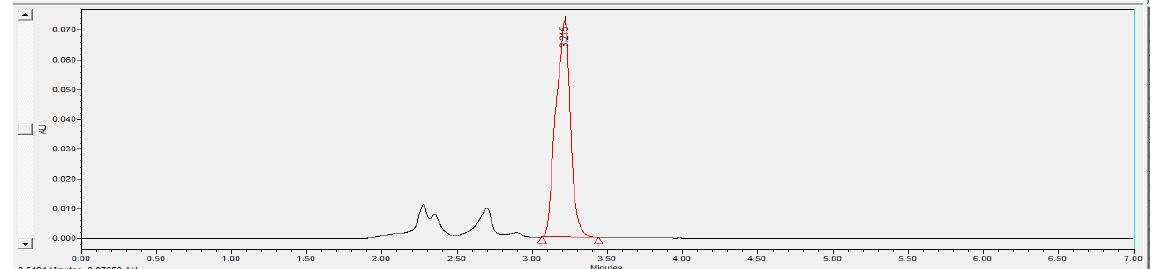
Figure 16. Chromatograms of wastewater samples containing phenols after treatment using Fe-Cu internal microelectrolysis material. Table 4. Parameters of coking wastewater before and after treatment using Fe-Cu materials.